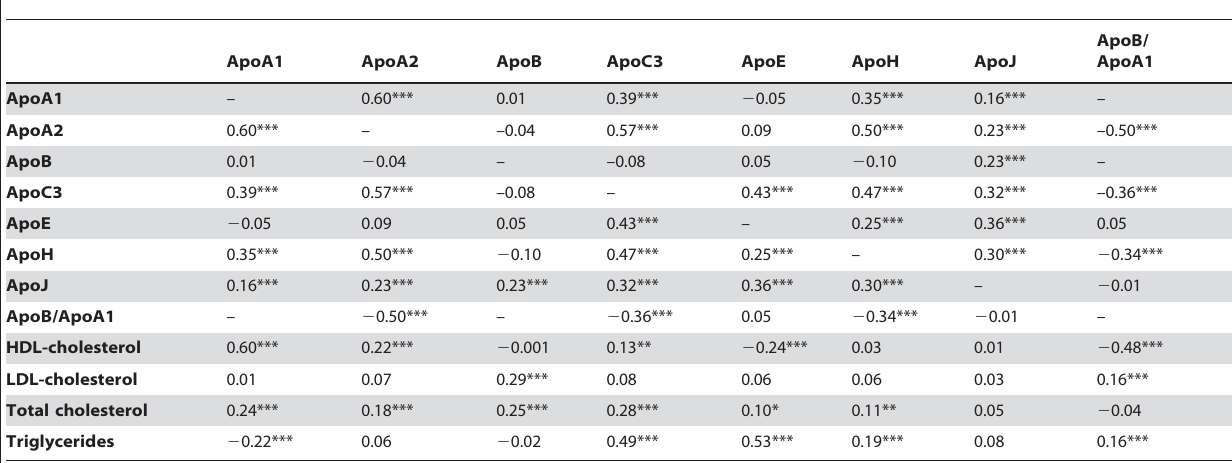
Table 3. Partial correlations between apolipoproteins and lipid profiles.